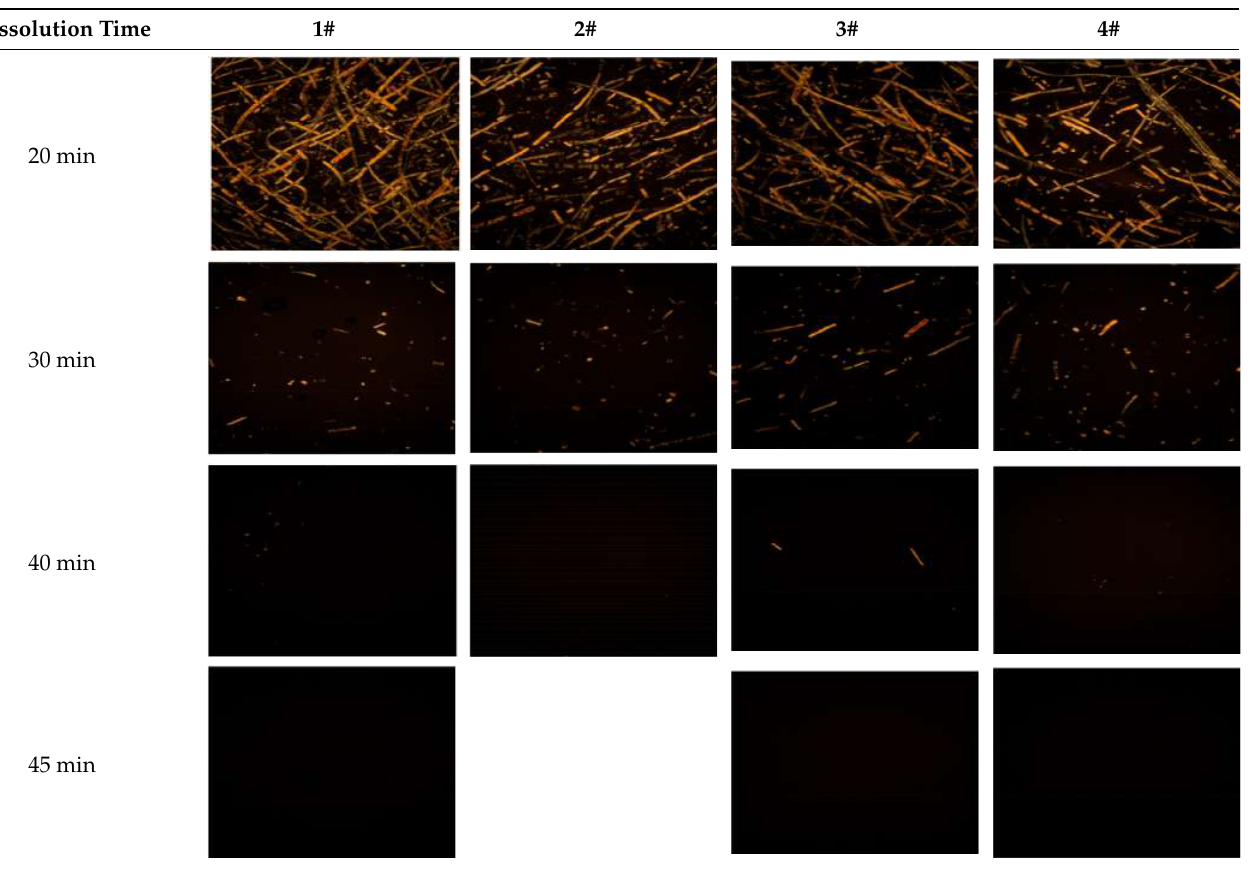
Table 5. Observation of dissolution